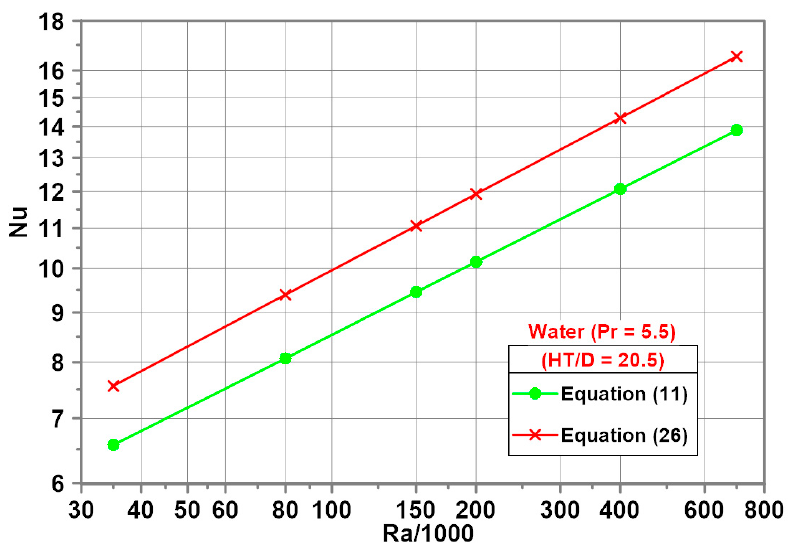
Figure 8. Present Nu-Ra relationship vs. predictions from literature correlation which relates Nusselt number to Rayleigh number and dimensionless submersion depth.